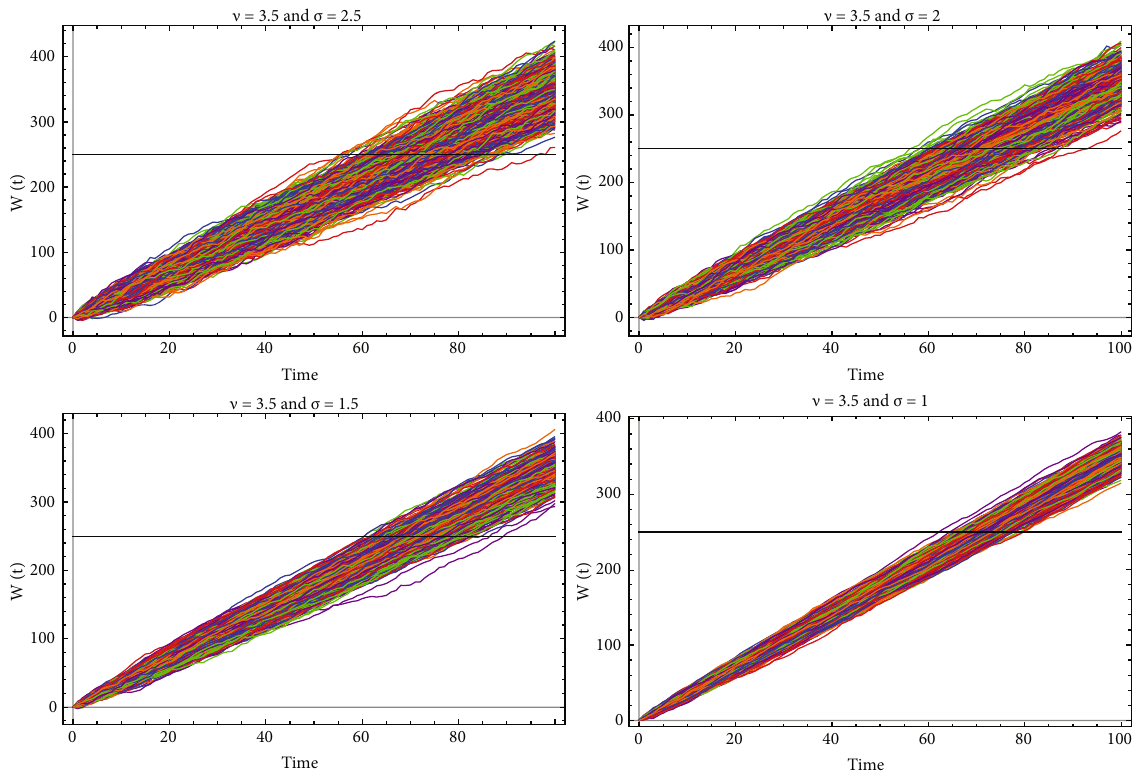
Figure 3: Simulated sample paths and threshold